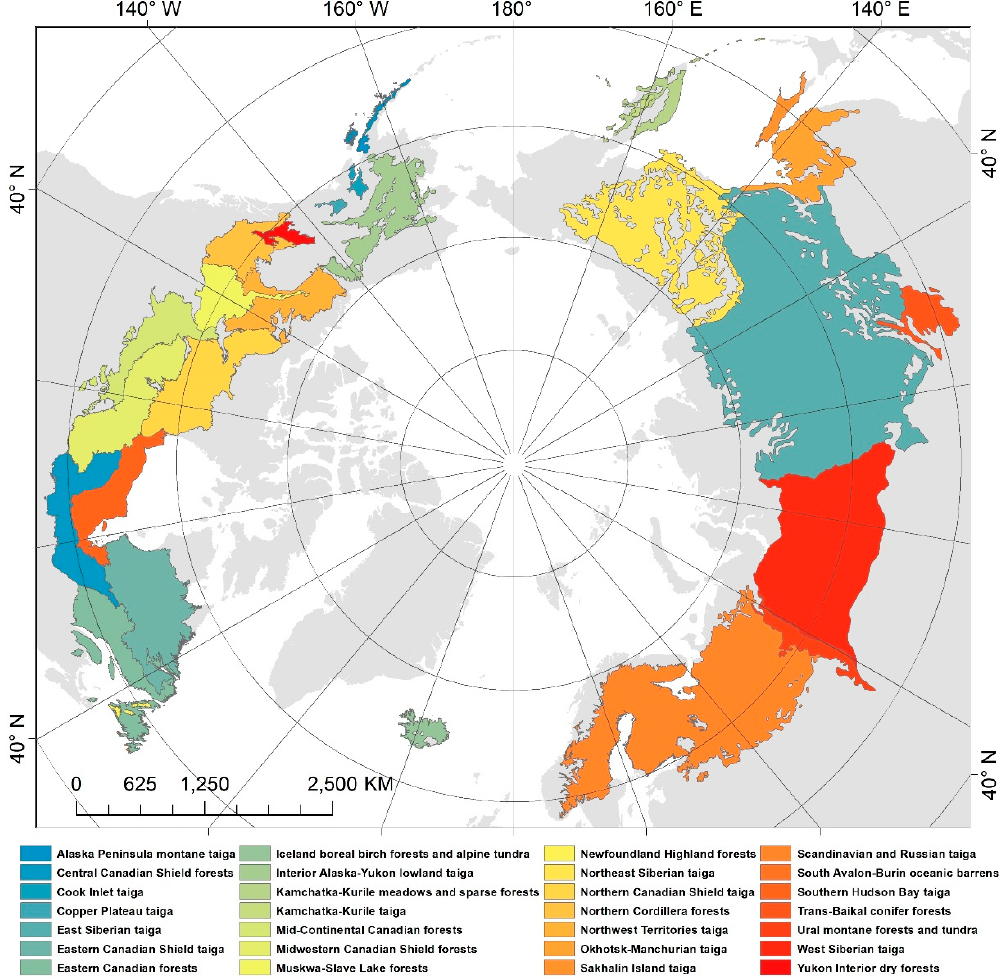
Figure A1. Boreal forest biome based on the Terrestrial Ecoregions of the World dataset. Table A1. Detailed information of the data sources used here.